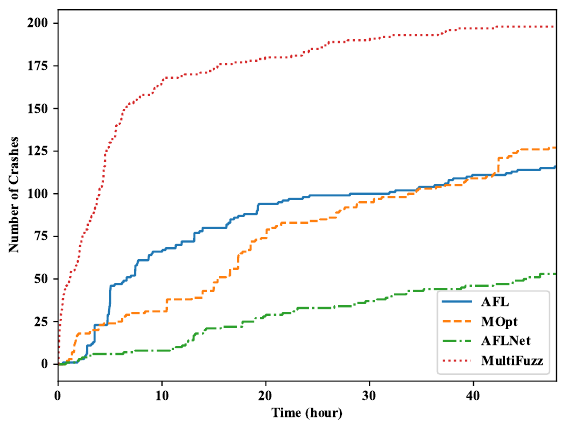
Figure 7. Crashes found in libcoap.